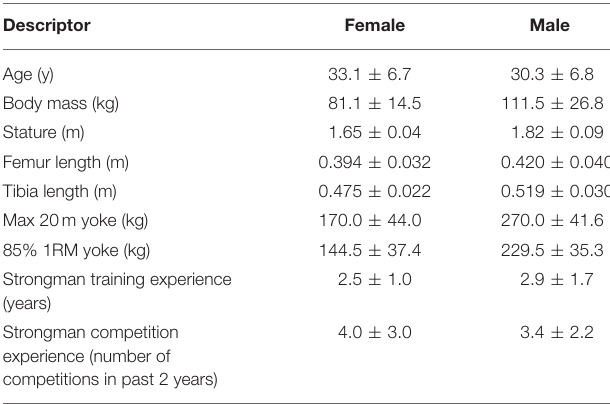
TABLE 1 | Participant